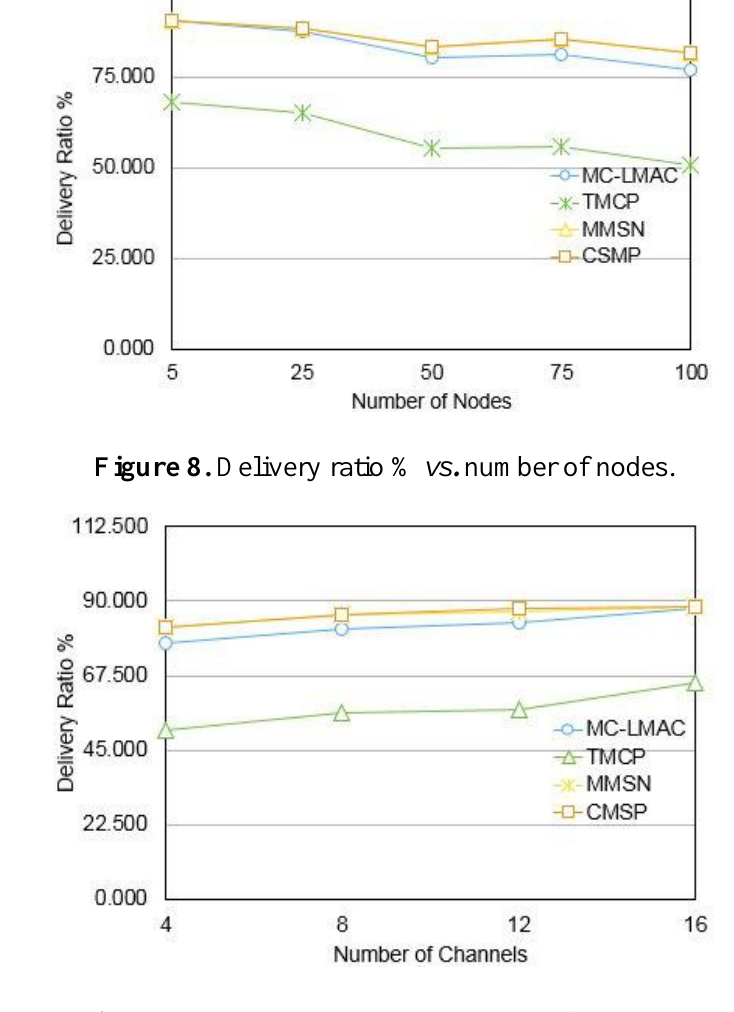
Figure 9. Delivery ratio % vs. number of